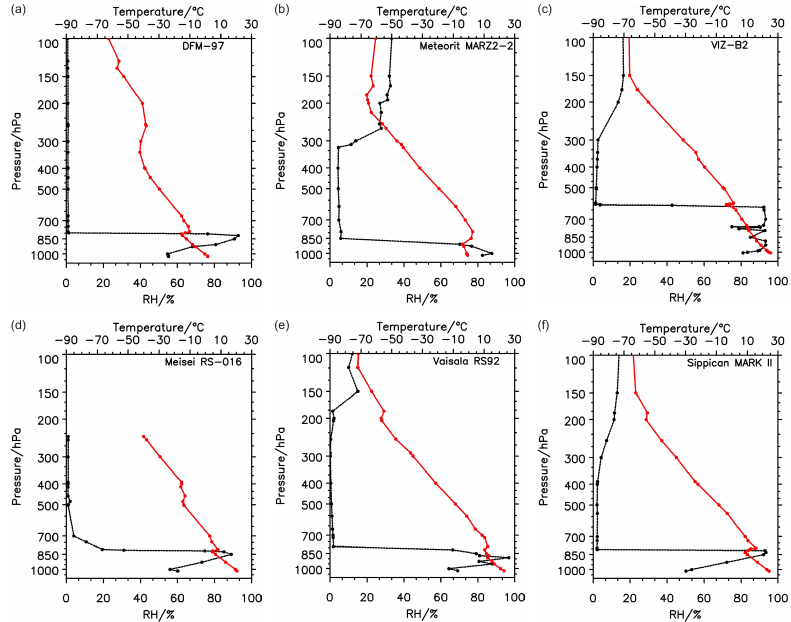
Figure 7. Relative humidity (black lines) and temperature (red lines) profiles for different types of radiosonde sensor: (a) DFM-97 (Gosan, Korea, 47185; 33.28 ◦ N, 126.15 ◦ E) at 12:00UTC (14 January 2009); (b) Meteorit MARZ2-type 2 (Kalac, Russian, 34247; 50.42 ◦ N, 41.05 ◦ E) at 00:00UTC (26 October 2009); (c) VIZ-B2 (Curacao, 78988; 12.12 ◦ N, 68.58 ◦ W) at 12:00UTC (17 December 2008); (d) Meisei RS-016 (Minamitorishima, Japan, 47991; 24.28 ◦ N, 153.98 ◦ E) at 12:00UTC (7 February 2009); (e) Vaisala RS92 (Galeao, Brazial, 83746; 22.82 ◦ S, 316.76 ◦ E) at 12:00UTC (21 May 2009); (f) US Sippican MARK II (Puerto Rico, 78526; 18.42 ◦ N, 294.03 ◦ E) at 12:00UTC (10 March